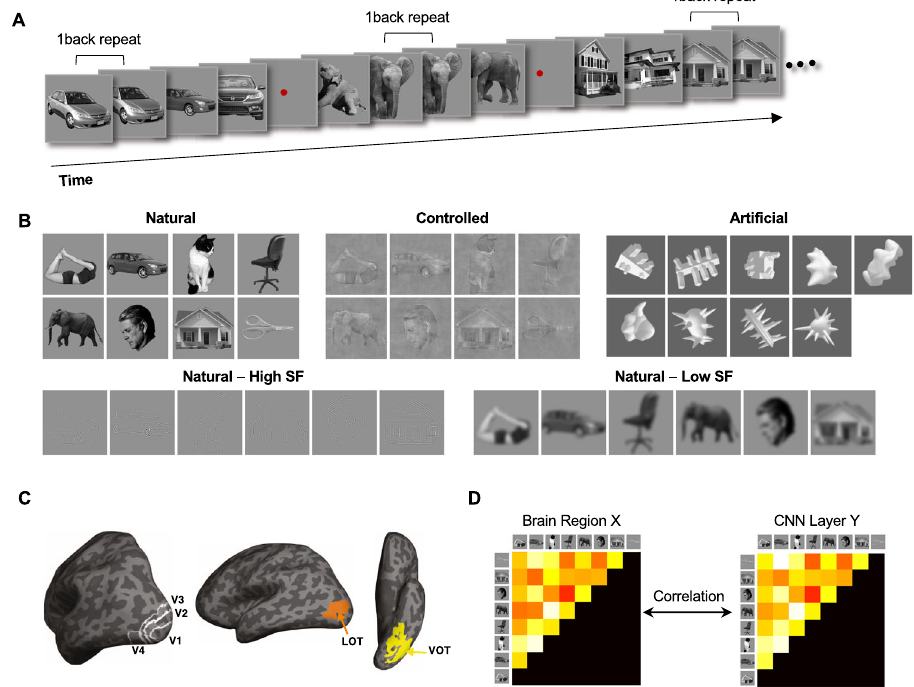
Fig. 1 Experimental procedure and stimuli used, brain regions examined, and the representational similarity analysis method used in the study. A An illustration of the block design paradigm used. Participants performed a one-back repetition detection task on the images. An actual block in the experiment contained ten images with two repetitions per block. See “ Methods ” for more details. B The stimuli used in the three fMRI experiments. Experiment 1 included the original and the controlled images from eight real-world object categories. Experiment 2 included the images from six of the eight real-world object categories shown in the original, high SF, and low SF format. Experiment 3 included images from the same eight real-world object categories and images from nine arti fi cial object categories. Each category contained ten different exemplars varying in identity, viewpoint/orientation, and pose (for the animal categories) to minimize the low-level image similarities among them. See Supplementary Figs. 1 and 2 for the full set of images used. C The human visual regions examined. They included topographically de fi ned early visual areas V1 – V4 and functionally de fi ned higher object processing regions LOT and VOT. D The representational similarity analysis used to compare the representational structural between the brain and CNNs. In this approach, a representational dissimilarity matrix was fi rst formed by computing all pairwise Euclidean distances of fMRI response patterns or CNN layer output for all the object categories. The off-diagonal elements of this matrix were then used to form a representational dissimilarity vector. These dissimilarity vectors were correlated between each brain region and each sampled CNN layer to assess the similarity between the two. C is reproduced from Xu and Vaziri- Pashkam 61 with